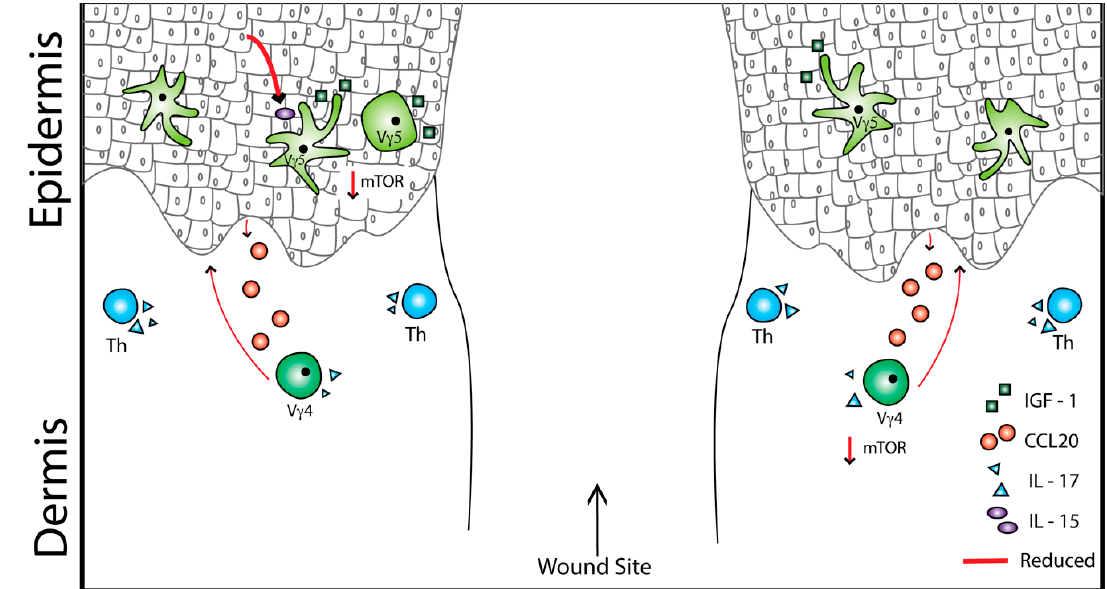
Figure 2. Obesity and type 2 diabetes cause alterations in cellular crosstalk that result in delayed wound repair. Epidermal γδ T cells become reduced in number, causing premature keratinocyte differentiation, epidermal thinning, and reduced production of interleukin-15 (IL-15) and IL-17. Upon wounding, the decreased number and function of γδ T cells result in a reduction in insulin-like growth factor-1 (IGF-1) and decreased keratinocyte proliferation. In addition, less chemokine ligand 20 (CCL20) is produced by keratinocytes, hindering the recruitment of dermal γδ T cells to the epidermis. Together, this leads to a delay in wound repair.